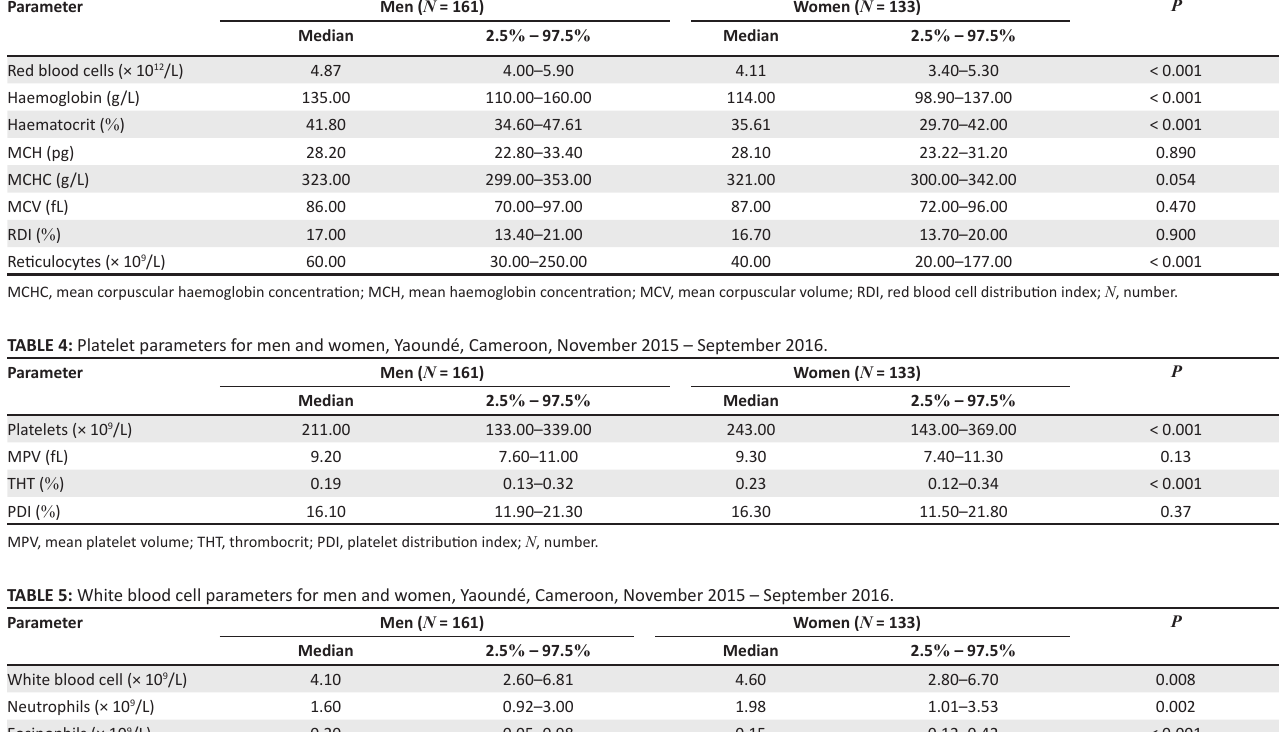
Neutrophils (× 10 9 /L)